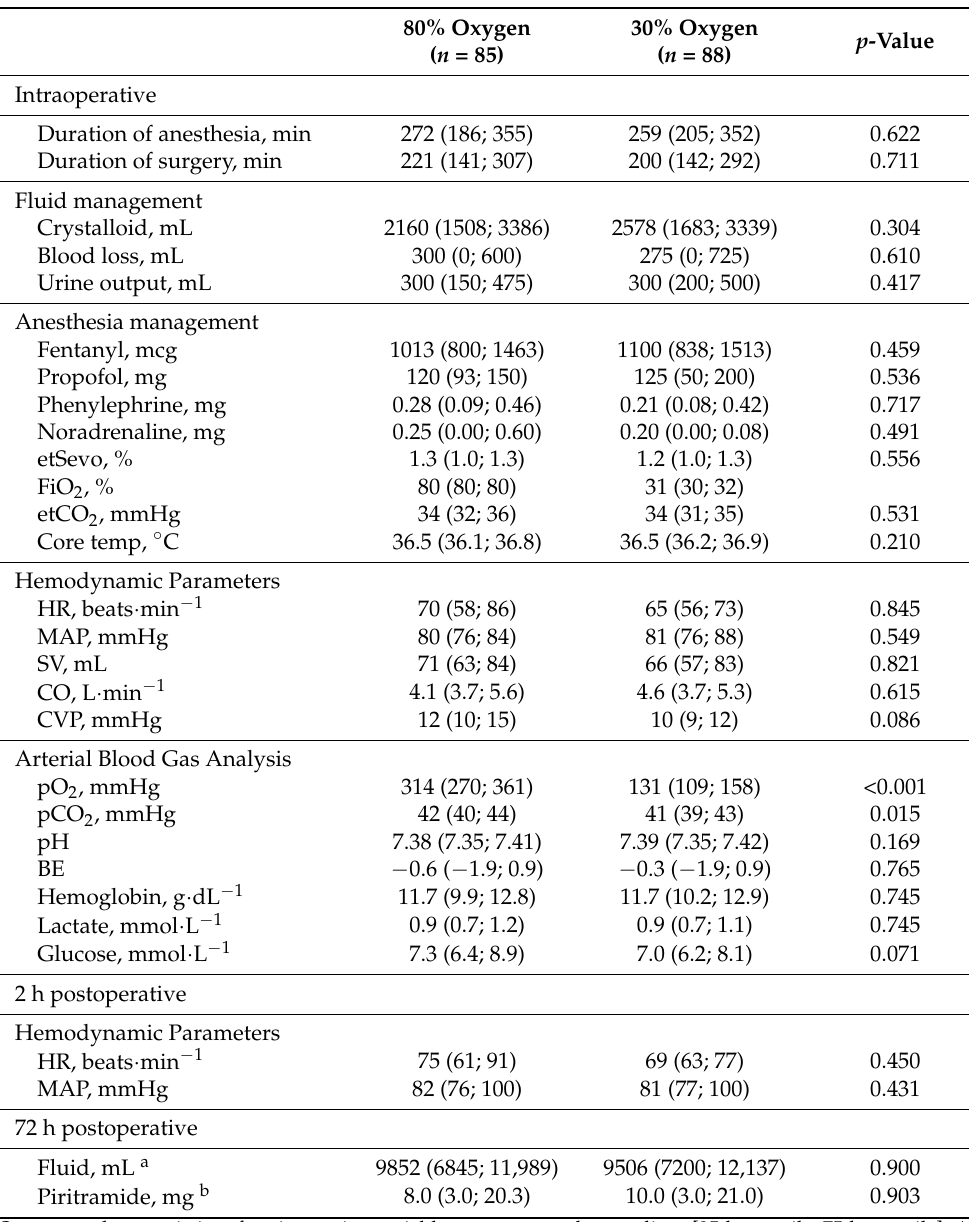
Table 2. Perioperative